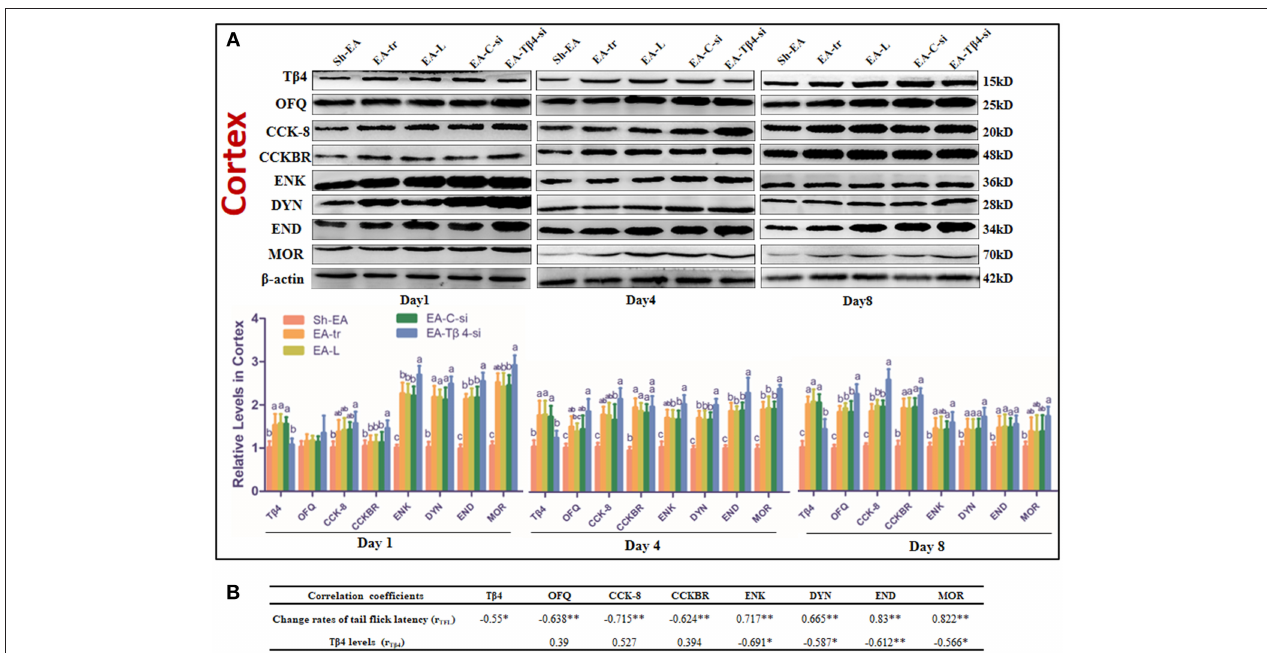
FIGURE 4 | (A) The effect of T β 4 siRNA on the levels of opioid and anti-opioid peptides and their receptors in the cortex of rats with repeated EA on day 1, 4, and 8 (mean ± SD, n = 6). The expressions of thymosin beta 4 (T β 4), orphanin FQ (OFQ), cholecystokinin octapeptide (CCK-8), CCK B receptor (CCKBR), endorphin (END), encephalin (ENK), dynorphin (DYN), and mu opioid receptor (MOR) were observed. The values with different letters (a-c) differ significantly in different groups at the same day ( P < 0.05). One-way ANOVA followed by Bonferroni’s post-test. (B) The correlation coefficients between the levels of opioid or anti-opioid peptides or their receptors and the change rates of tail flick latency (TFL) or T β 4 levels. * P < 0.05, ** P < 0.01. The correlation coefficient was analyzed with Pearson’s correlation coefficient.